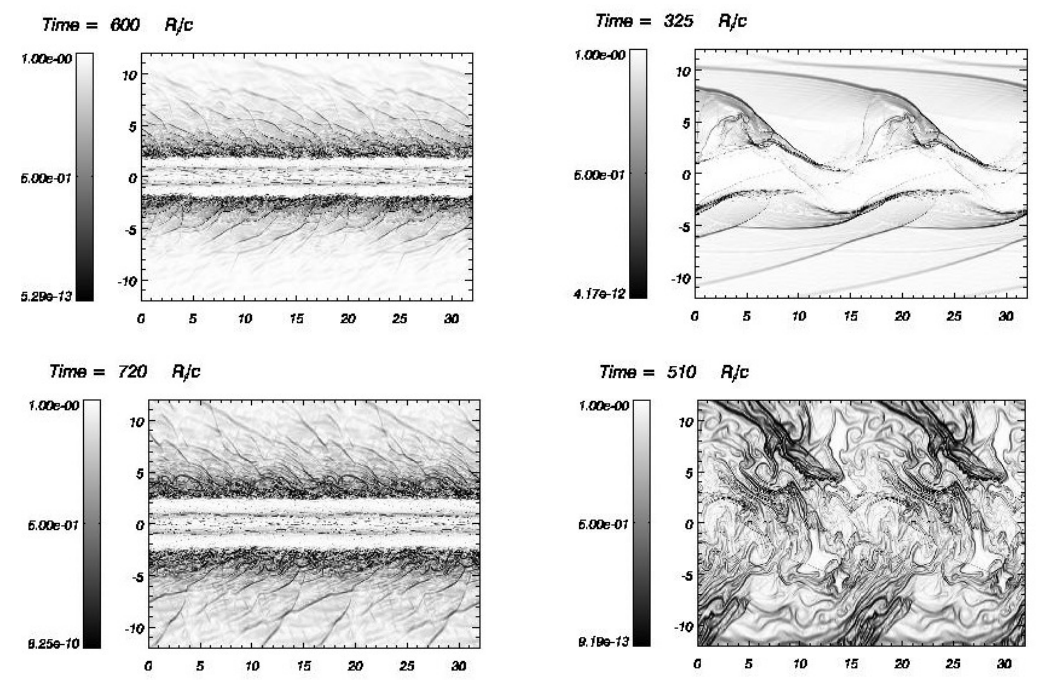
Figure 1. Schlieren plots (enhanced rest-mass density gradients showing waves and shocks) from numerical simulations of two jets at different times [101]. The left column shows the evolution of a jet (fast and relatively cold) in which resonant modes develop at the shear-layer; as a result of the strong dissipation caused by these modes, a thick, hot layer develops surrounding the collimated flow that preserves basically unchanged properties [100]. The right column shows the evolution of a slower jet, in which resonant modes do not dominate the growth rates at the linear regime; in this case, the jet is disrupted by the long-wavelength helical